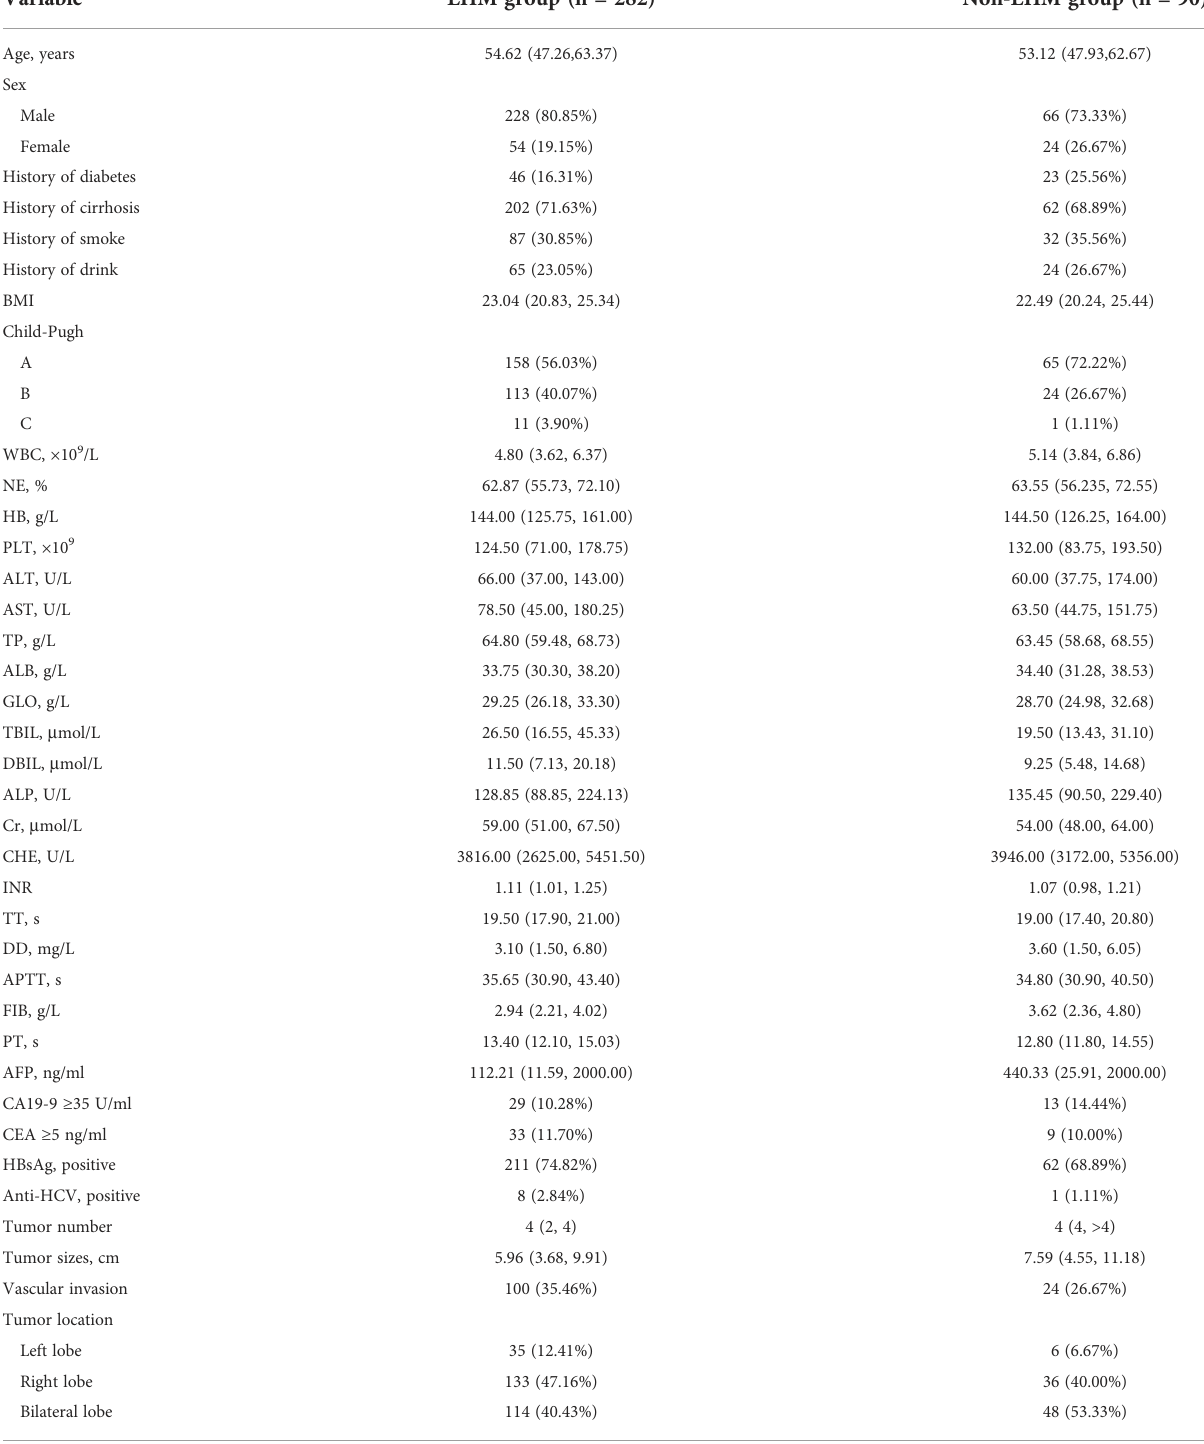
TABLE 3 Baseline clinical characteristics of followed up